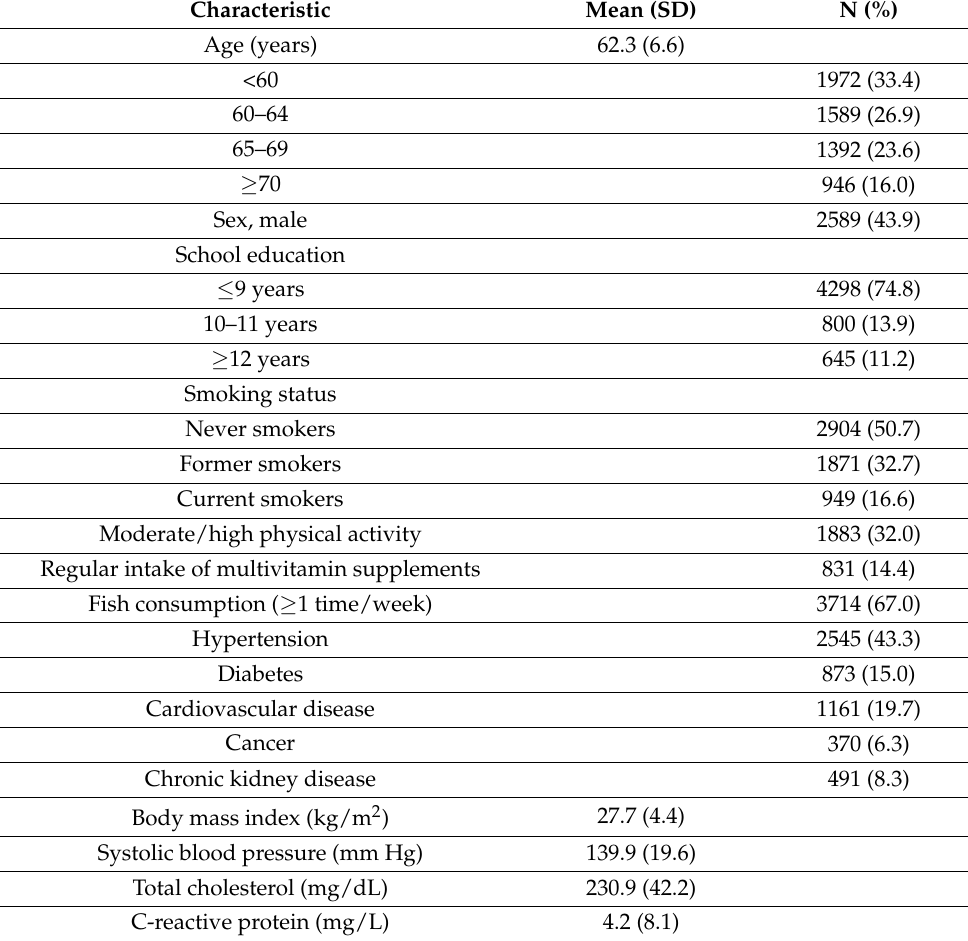
Table 1. Baseline characteristics of the study participants (N =